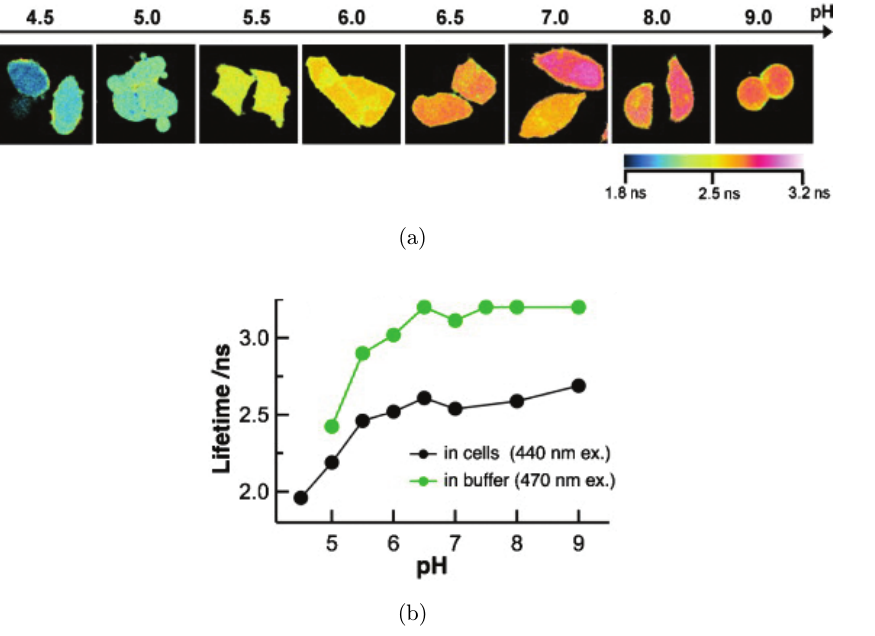
Fig. 2. (a) The correlation between °uorescence lifetime of EYFP expressed in HeLa cells and intracellular pH. (b) Dependence of average EYFP °uorescence lifetime on pH in cells and bu®er